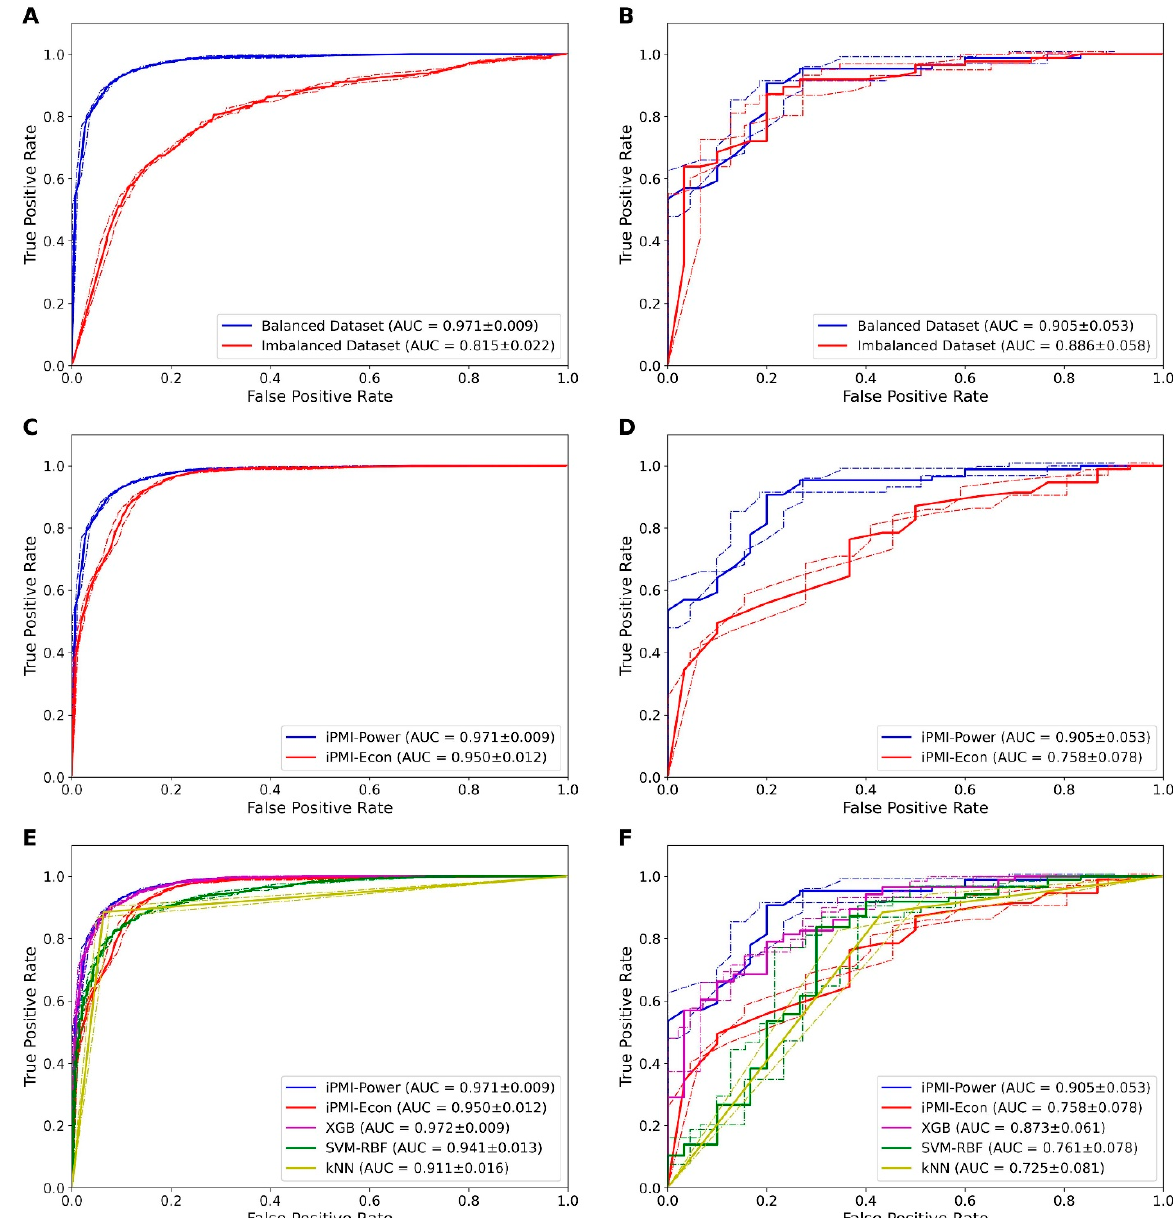
Figure 1. ROC curves of RF models trained using different feature sets based on the 10-fold cross-validation test ( A , C , E ) and independent test dataset ( B , D , F ): ( A , B ) illustrate comparison of RF models with and without the oversampling technique SMOTE; ( C , D ) illustrate comparison of iPMI-Power and iPMI-Econ, where iPMI-Power and iPMI-Econ are constructed by RF models trained using the combination of baseline+pelvicme+utmet and baseline factor, respectively; and ( E , F ) illustrate a comparison of the proposed models (i.e., iPMI-Power and iPMI-Econ) with kNN, SVM-RBF and XGB. The AUC values are expressed with 95% confidence